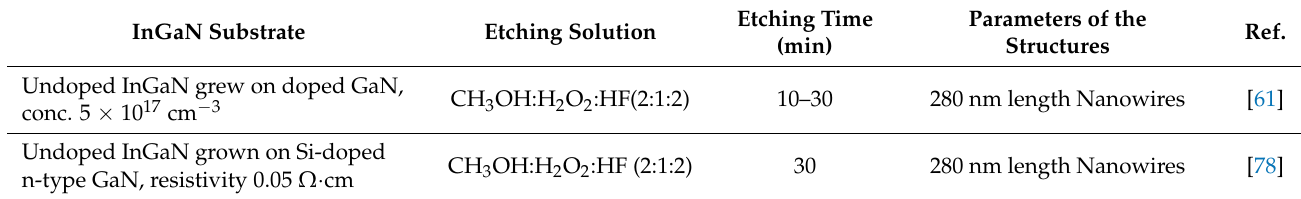
Etching Time Parameters of the Ref. (min) Structures